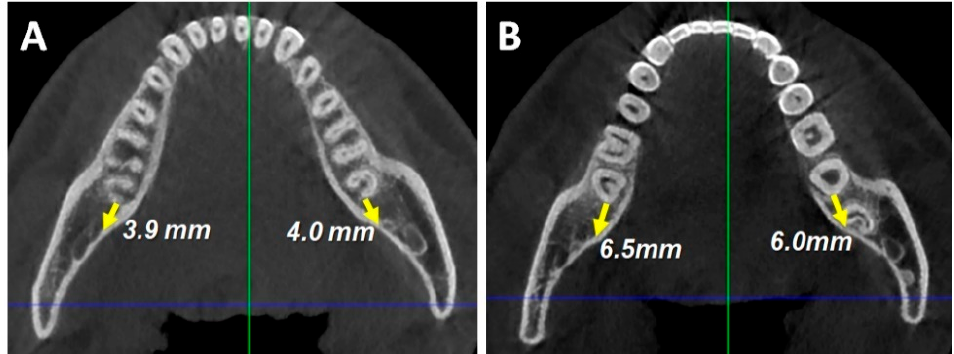
Figure 5. Posterior available spaces for distalization of the mandibular posterior teeth on CBCT axial images. ( A ) At root apex level. ( B ) At cementoenamel junction (CEJ) level.